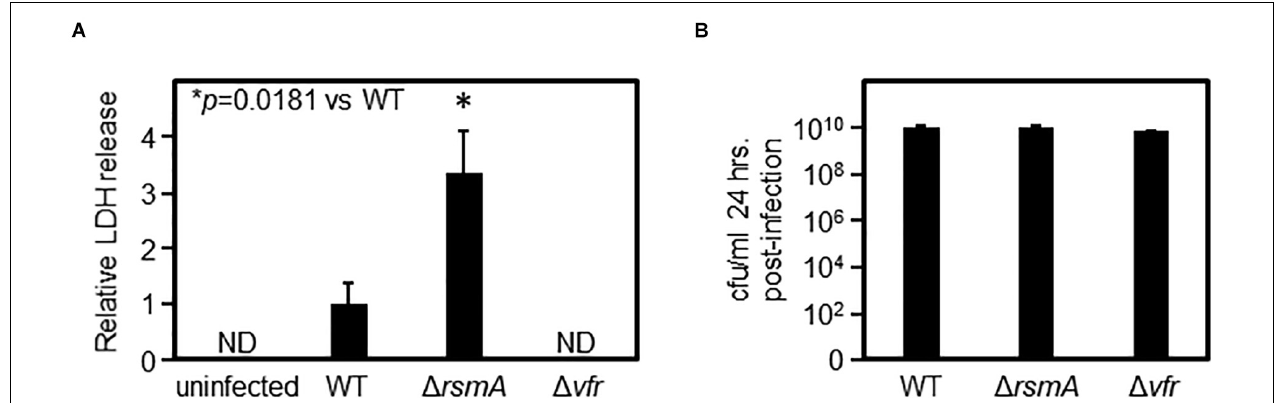
FIGURE 3 | (cid:49) rsmA displays an increased virulence phenotype against tissue culture cells. (A) After retinal pigment epithelial (RPE) cells were infected by Pseudomonas aeruginosa strains for 24 h, the levels of lactate dehydrogenase (LDH) in the media were measured. The increase of LDH released into the media by (cid:49) rsmA -infected cells as compared with WT-infected cells indicates increased RPE cell lysis and, therefore, increased cytotoxicity caused by the (cid:49) rsmA strain. (cid:49) vfr is defective in this virulence assay, as no LDH could be detected in the media. The y -axis values are expressed as relative to WT as 1. ND, not detected. (B) Bacteria were retrieved from the wells of infected RPE cells, plated on agar media from a serial dilution series, and subsequently enumerated by counting colonies to determine colony-forming units (cfu) per milliliter. The identical cfu · ml − 1 for all three strains demonstrate that the differences in virulence as measured by LDH release in panel (A) is not due to an imbalance in bacterial